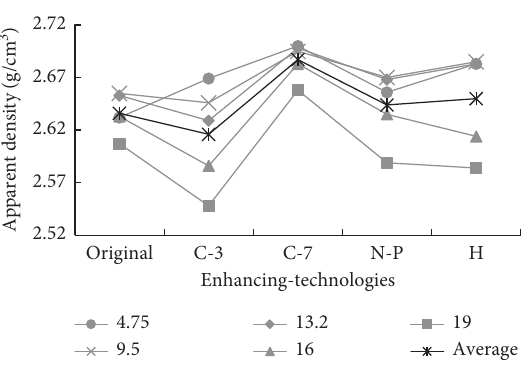
Figure 4: Average value of apparent density of RA before and after chemical enhancing-technology.